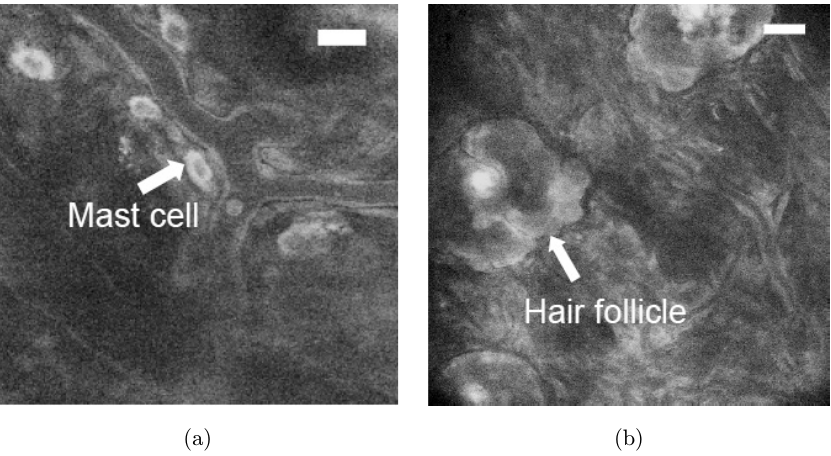
Fig. 1. Mast cells imaging with tryptophan auto°uorescence (a) dermal mast cells in BALB/c mice reside close to blood vascu- lature, (b) mast cells are not present in mast cell-de¯cient mice (B6 W/W V ) dermis. (Bar: 20 (cid:4) m in (a), and 30 (cid:4) m in